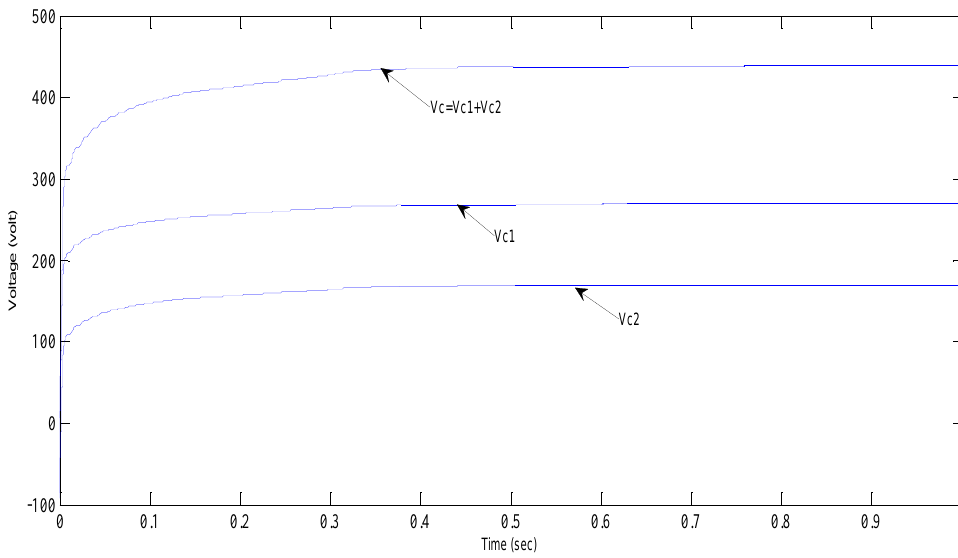
Figure 24. Source-side boost voltage across the capacitor of qZS-CHBMLI .